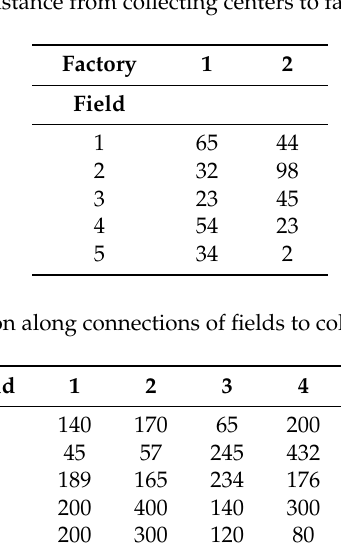
Table 5. Distance from collecting centers to factories (km).